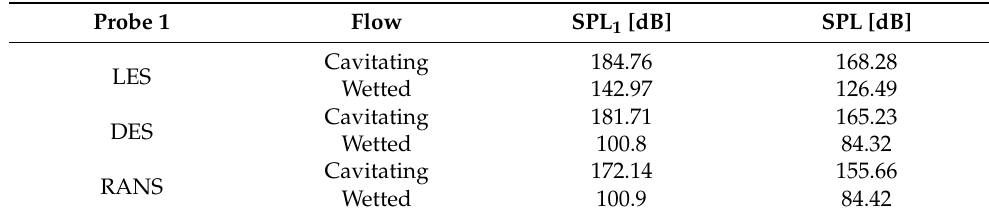
Table 10. Comparison difference of SPL 1 and SPL according to cavitating flow and wetted flow.